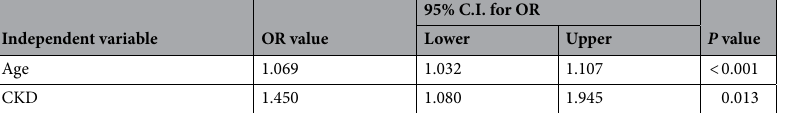
Table 3. Logistic regression analysis of related factors of sarcopenia. CKD chronic kidney disease stages 1–5, CI confidence interval, OR odds ratio, SE standard